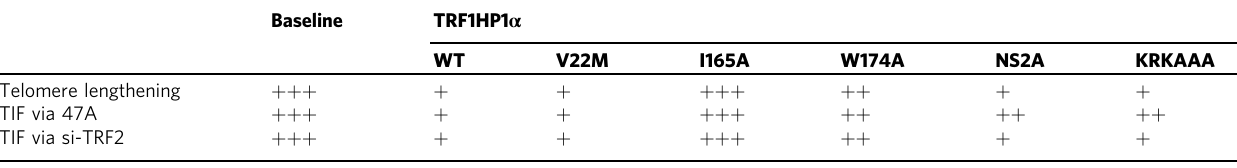
Table 1 Summary of experimental data describing impact of WT versus mutants TRF1HP1 α on telomere lengthening and TIF (via 47A or TRF2